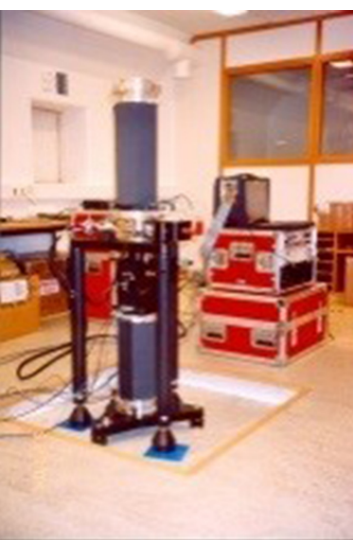
Figure 6. The free-fall absolute gravimeter